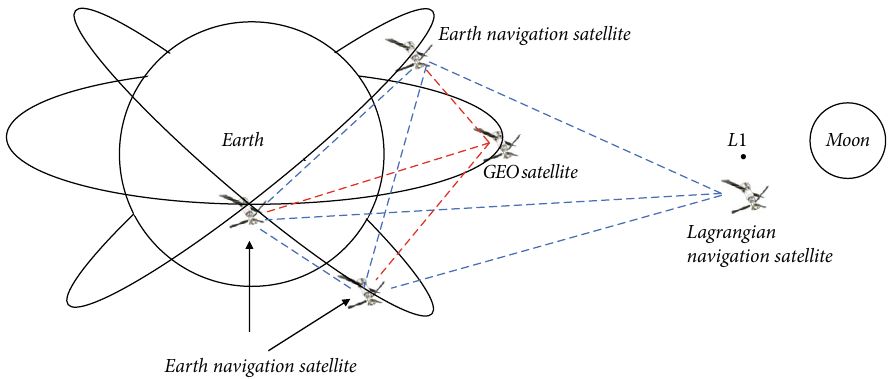
Figure 1: GEO satellite observation